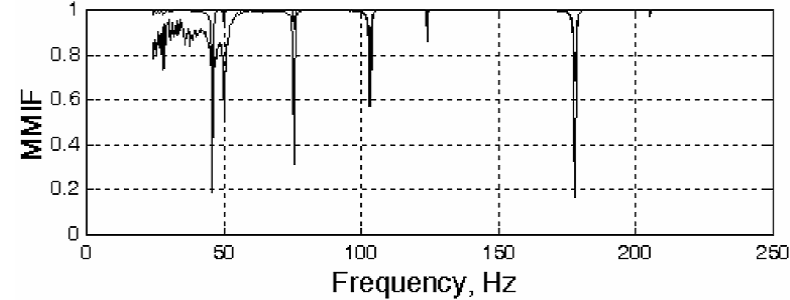
Fig. 22. MMIF for the test structure.